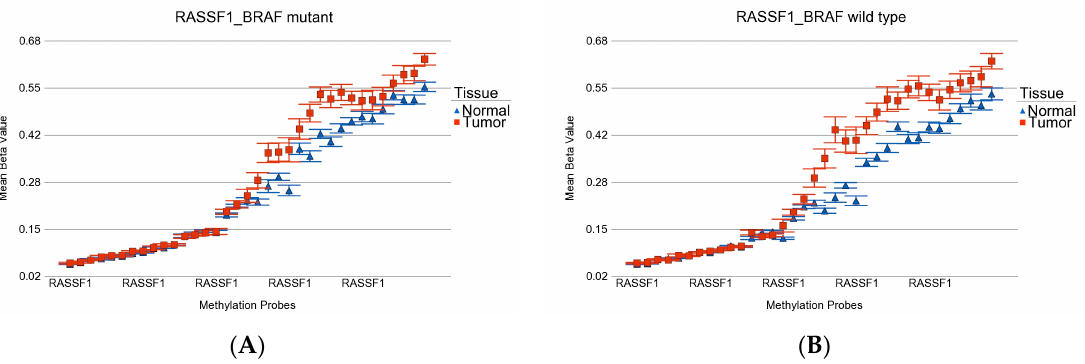
Figure 8. Differential methylation status of RASSF1 . Differential methylation in BRAF mutant patients is shown in ( A ), and the differential methylation of BRAF wild-type patients is shown in ( B ). Multiple probes were hypermethylated in both groups. However, the overall magnitude was slightly higher in wild type.